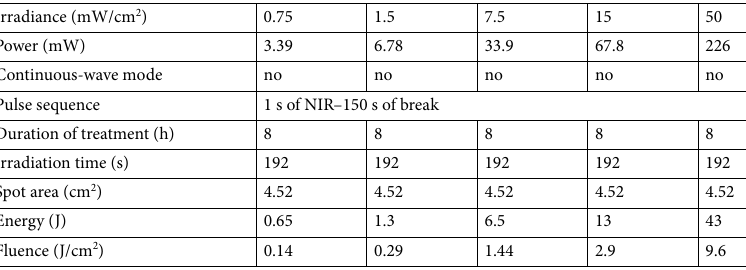
Table 1. Photobiomodulation parameters—irradiance dependent dosing of